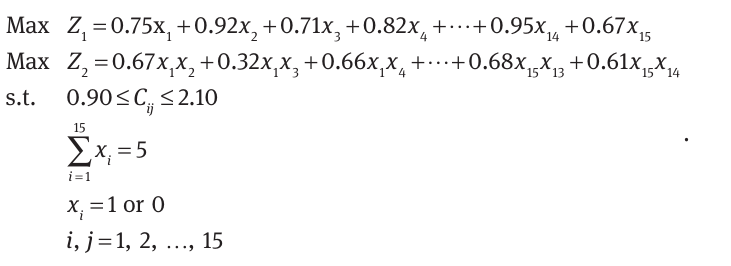
Table 5: Original Data on Criteria R